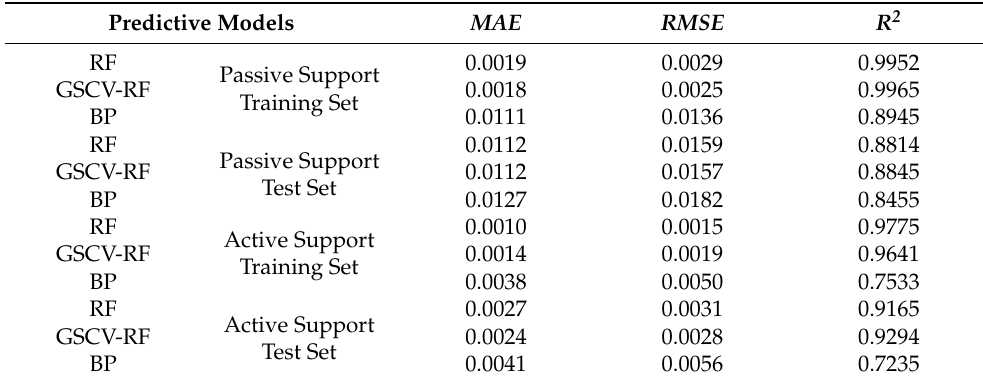
Table 8. Quantitative evaluation of the model